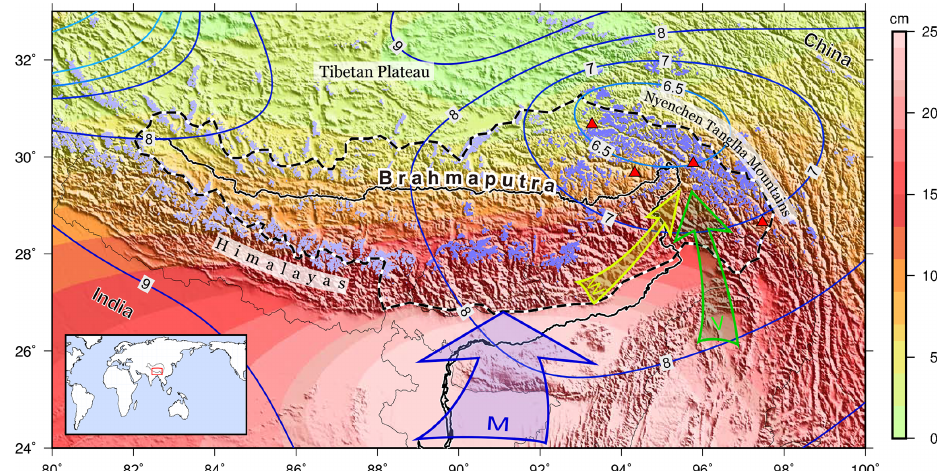
Figure 1. Geographic environment of the upper Brahmaputra basin. The boundary of the basin is outlined by the dashed black line. The violet areas in the plateau represent mountain glaciers, but only the darker ones (9679km 2 in total) are studied here. The background colour shows the amplitudes of annual variation in terms of equivalent water height from GRACE, and their peak months (the month with the peak value in a year) are indicated using contours (e.g. 9 means September). The red triangles mark the locations of four meteorological stations. The coloured arrows illustrate major climatic factors influencing this region (M: Indian monsoon; W: westerly winds; V: Bay of Bengal vortex). The red box in the inset marks the location of the study area. Table 1. Previous model-based estimates of meltwater contribution to the Brahmaputra discharge. Amount of Drainage meltwater Total discharge Meltwater / total Study literature Time